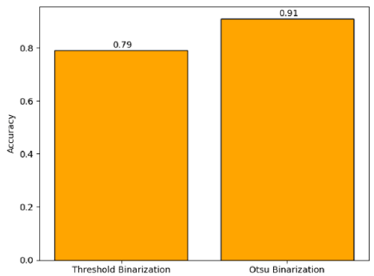
Fig. 8 The comparison of Otsu and threshold